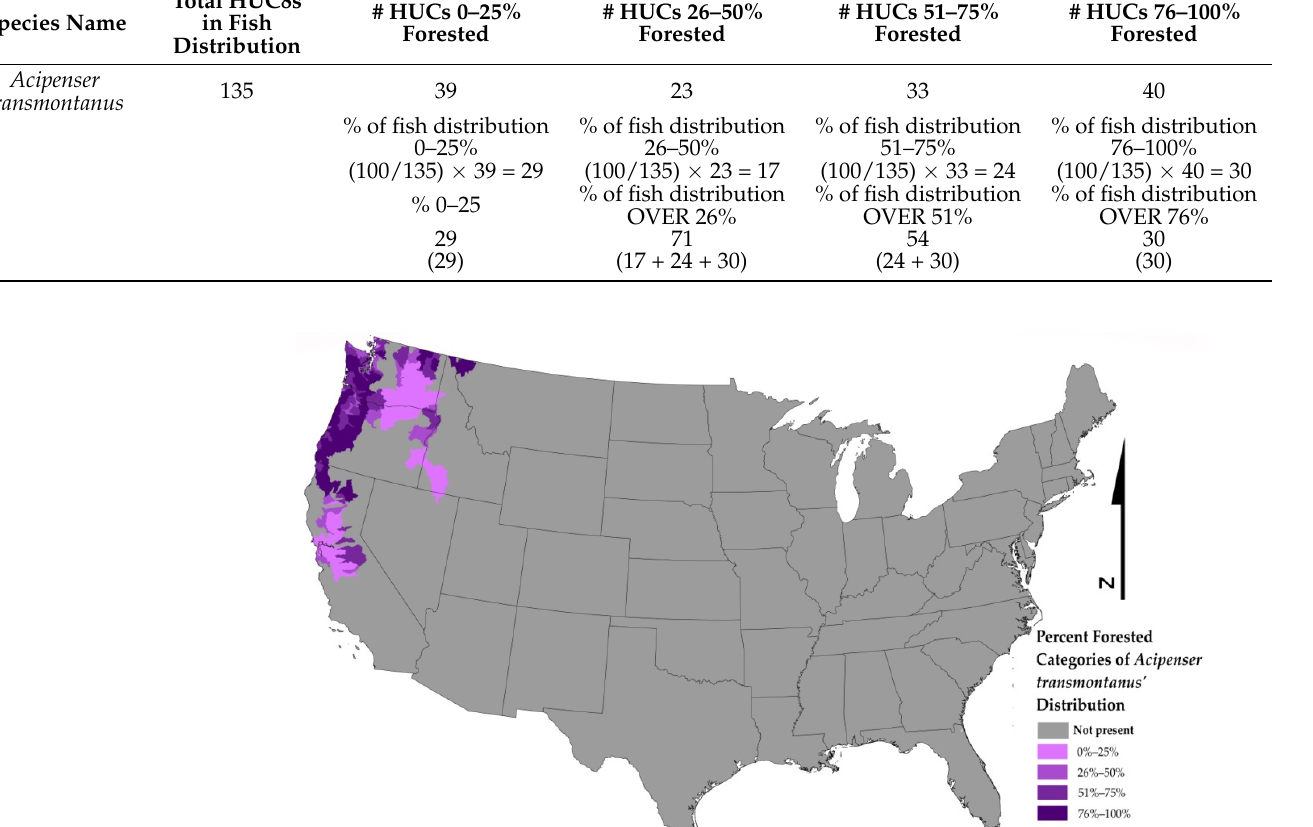
Figure A1. Range of White Sturgeon ( Acipencer transmontanus ) with the four levels of forested area of the HUC8 units. Of the 135 HUCs in the distribution, 39 HUCs are in the least forested category (0–25%), 23 in the low forested category (26–50%), 33 in the moderately forested category (51–75%), and 40 HUCs are in the highly forested category (76–100%).